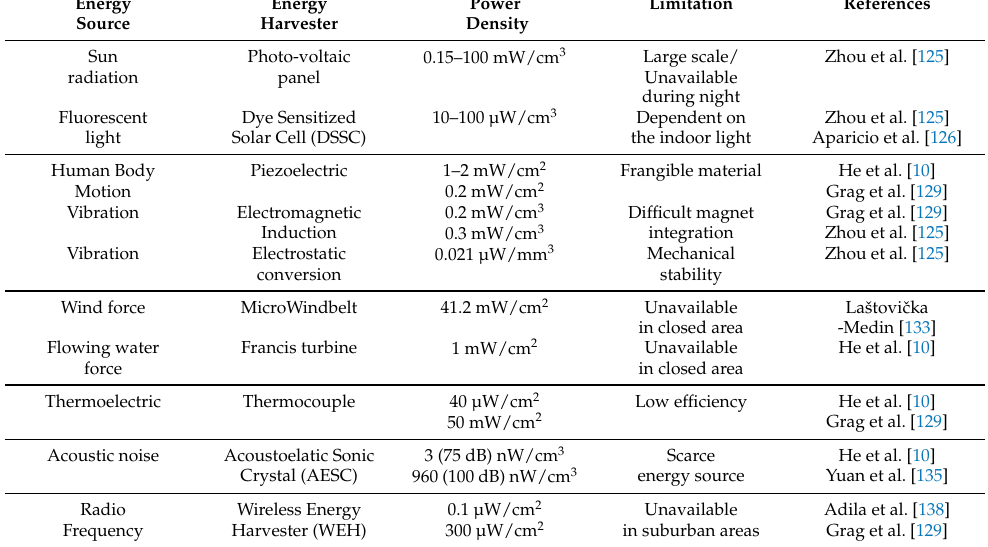
Table 5. Various energy harvesting